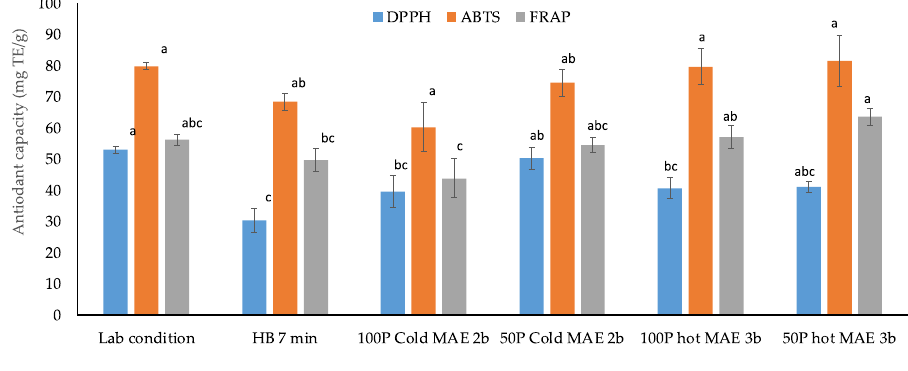
Figure 9. Antioxidant properties of herbal tea infusion prepared from different extraction methods. Data are means ± standards deviations. Data for each antioxidant assay (DPPH, ABTS, or FRAP) not sharing similar letters are significantly different at p < 0.05.